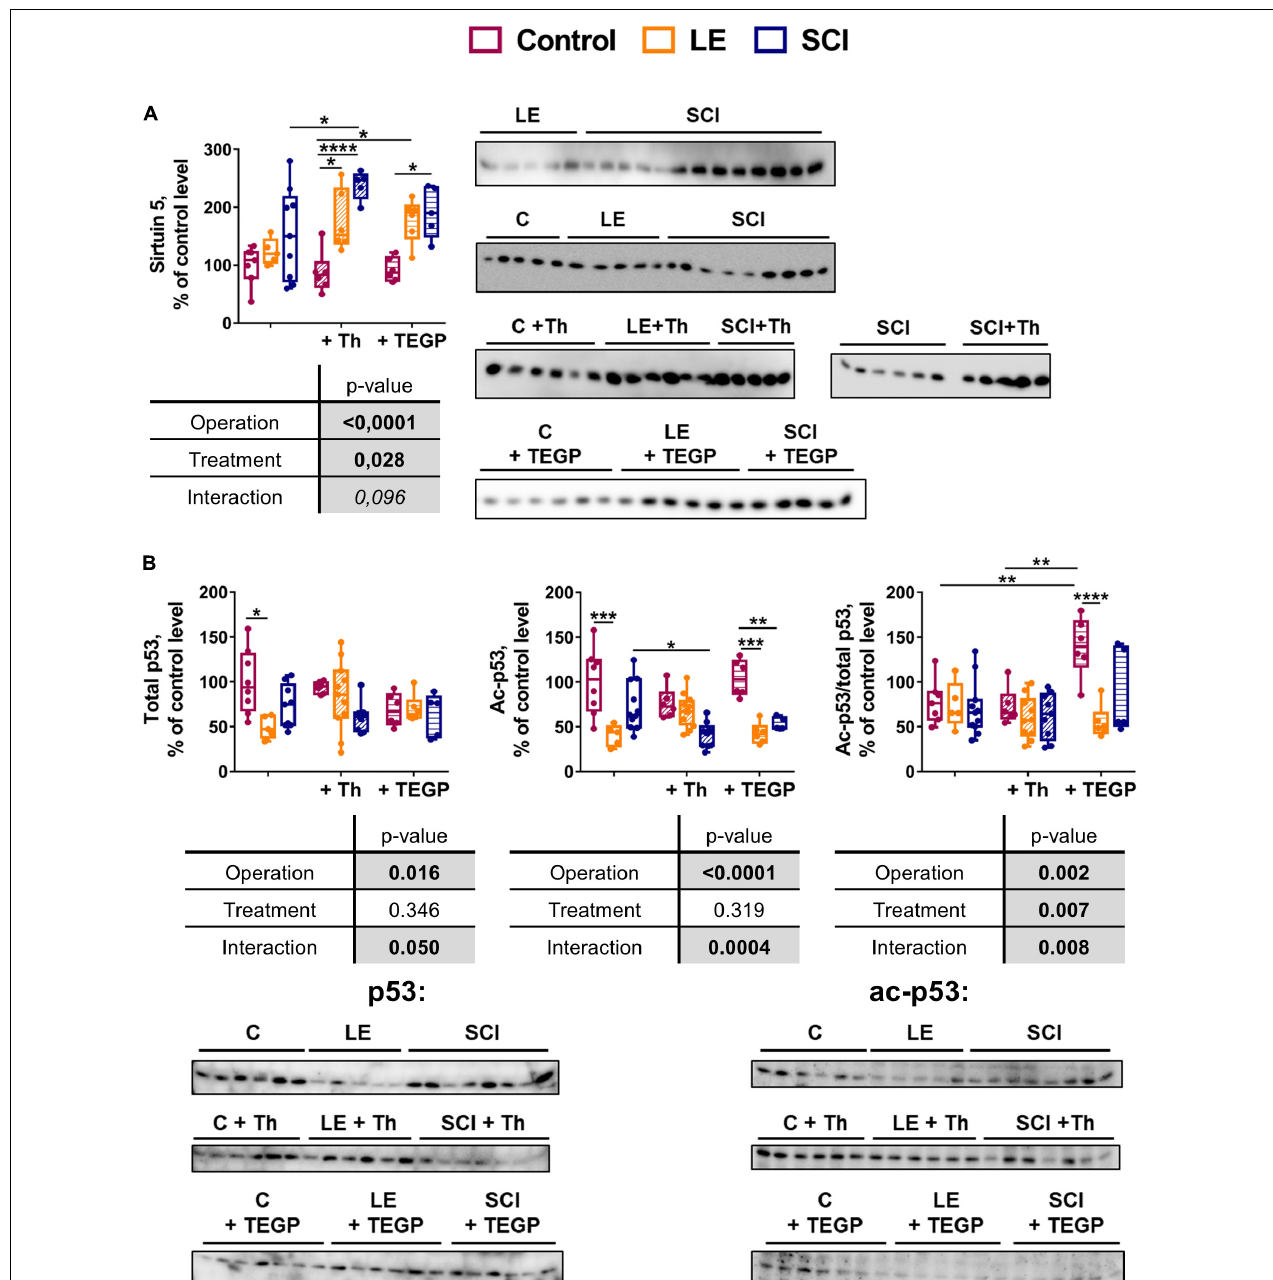
FIGURE 8 | Comparison of the effects of the OGDHC regulators thiamine (Th) and TEGP on the expression of sirtuin 5 (A) and total or acetylated p53 (B) in cerebral cortex of the experimental rat groups. The expression is assessed by the western-blotting procedures described in Methods. Data for the different animal groups are expressed as percentage of the corresponding values determined in the non-operated (control, C) rats. The two-way ANOVA and post hoc Tukey’s test are used to determine statistical significance of differences. On the graphs, different p -values are shown by asterisks as described in Methods under Statistical Analysis. In the tables, significances ( p ≤ 0.05, in bold), according to the two-way ANOVA, are highlighted in gray. Only the statistically significant differences between the pairs of groups varying in a single factor (operation or treatment), are